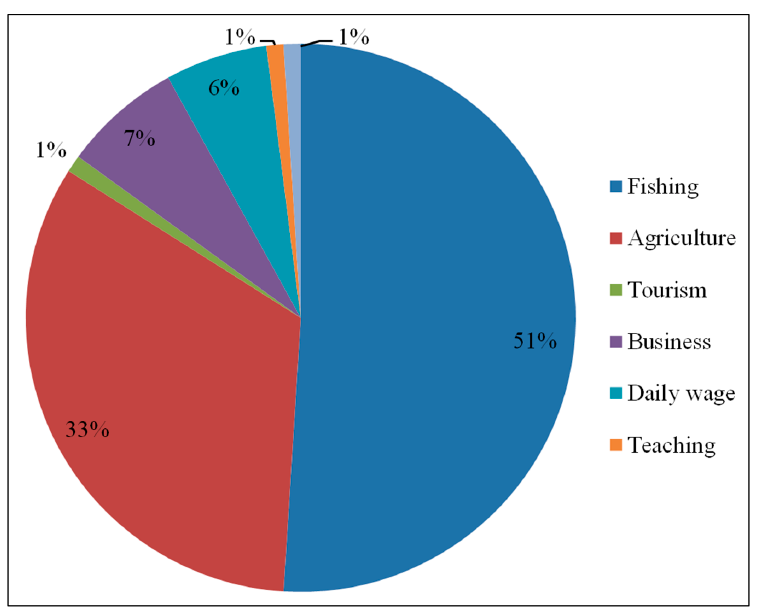
Figure 2. Livelihood strategies of the locals in the Maguri-Motapung Beel.